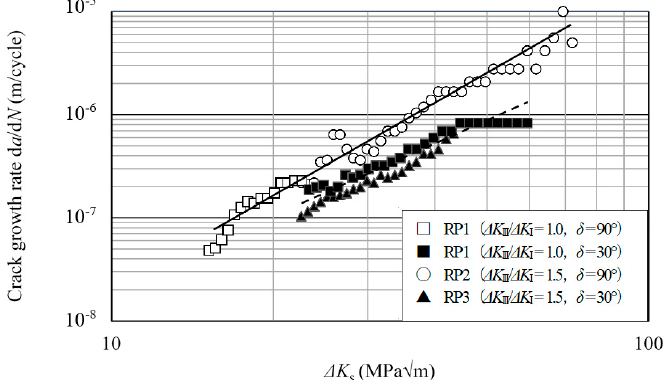
Figure 7. Coplanar crack growth rates against ∆ K s for